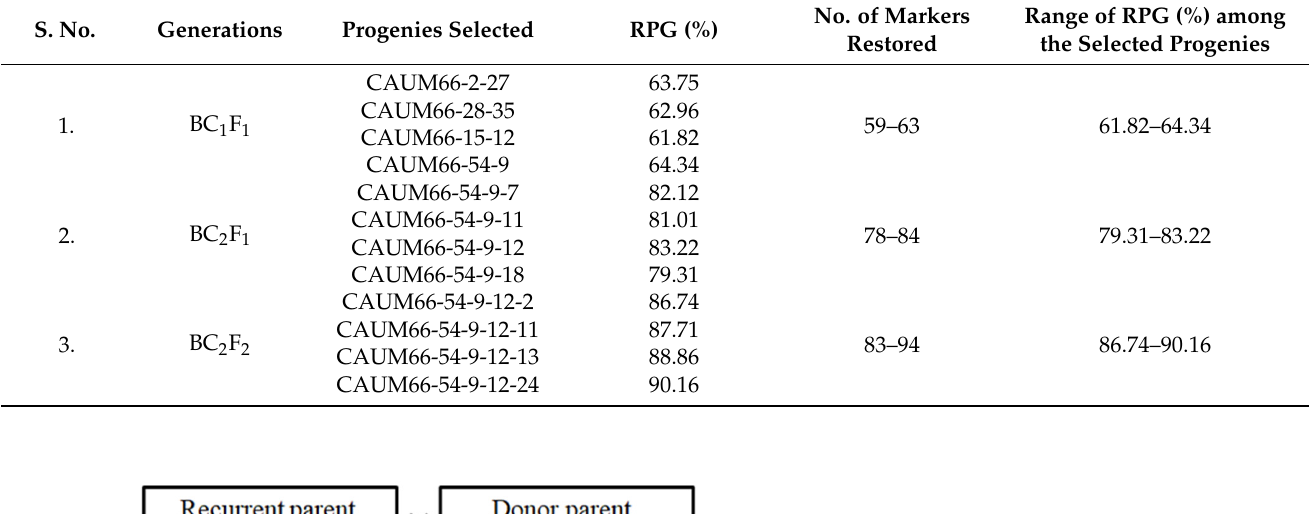
Table 2. Details of the recurrent parent genome recovery (RPGR) in the foreground positive plants.